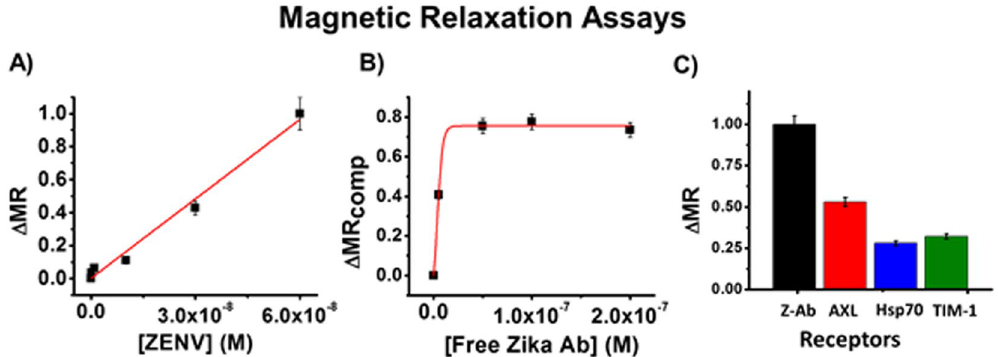
Figure 2. ( A ) Z-Ab-MRNPs (1.5 mM) were incubated with ZENV (0 to 6E − 8 M) for 30 minutes at 25 °C, resulting in increasing ∆ MR values as binding increased between Z-Ab-MRNPs and ZENV. ( B ) Z-Ab-MRNPs were incubated with ZENV (3E − 8 M) and free Z-Ab (0 to 2E − 7 M). ( C ) MRNPs conjugated with Z-Ab, AXL, HSP70, and TIM-1 were incubated with ZENV (3E − 8 M). As shown, AXL exhibited the strongest binding among the proposed receptors. Average values of three measurements are depicted ± standard